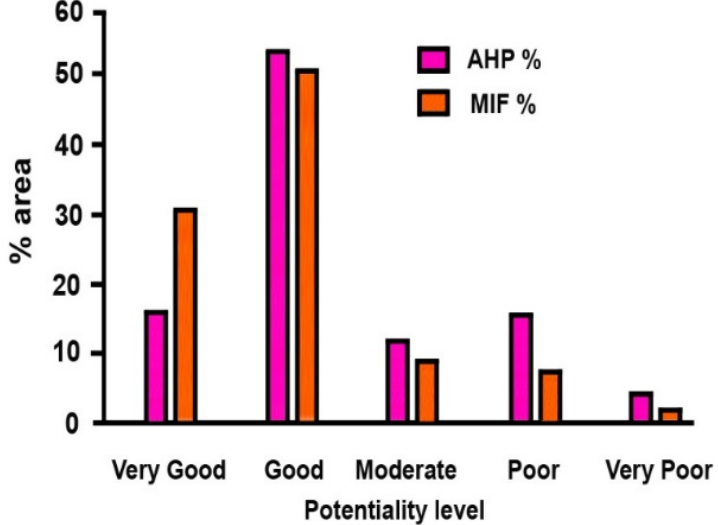
Figure 9. Distribution of groundwater recharge classes for AHT and MIF in the study area.